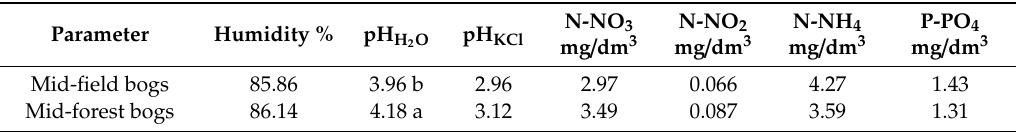
Table 7. Characteristics of peat soils of mid-field and mid-forest bogs. Mid-forest bogs (N1-3 and